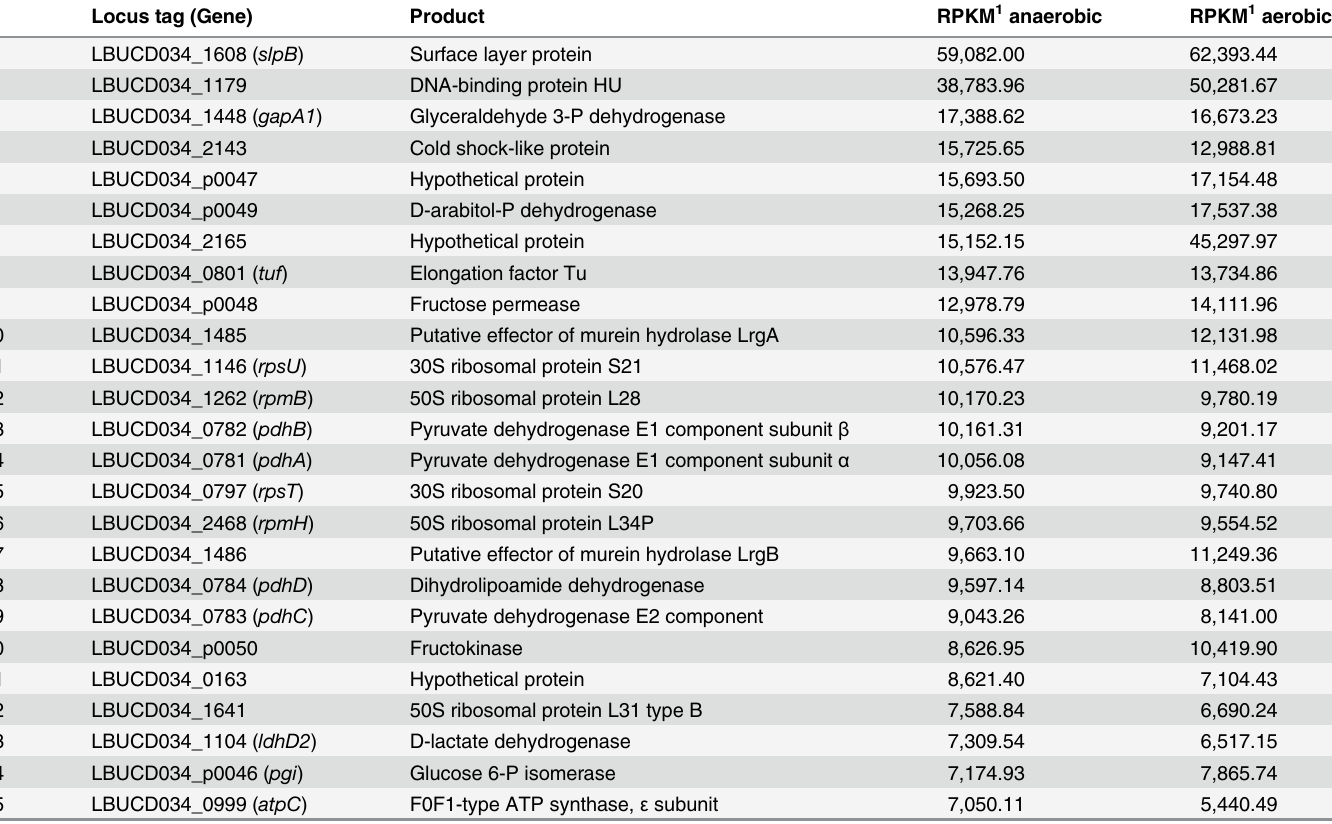
Table 2. The 25 most abundantly transcribed genes of L . buchneri CD034 cultivated under aerobic vs . anaerobic conditions. Locus tag